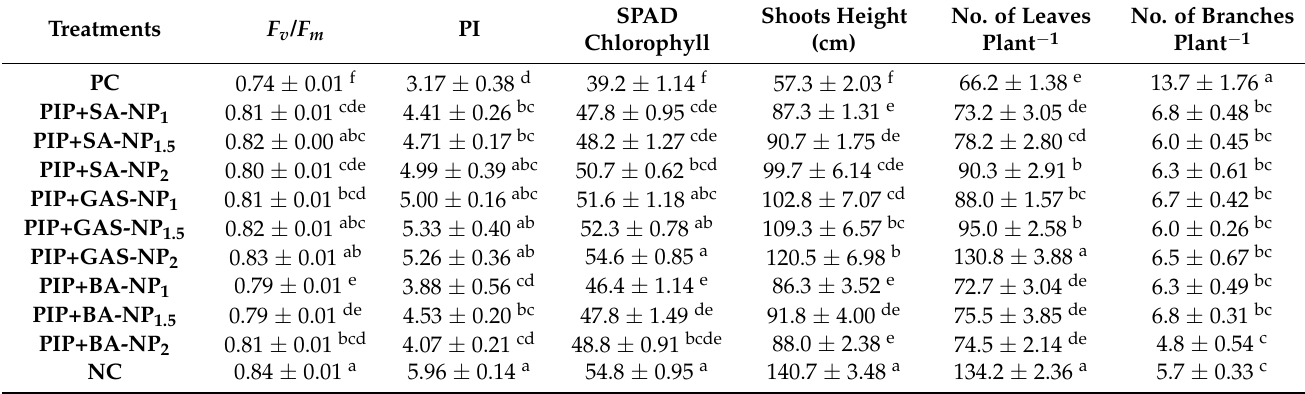
Table 3. Effects of foliar-applied salicylic acid (SA-NP), glycyrrhizic acid (GAS-NP), and boric acid (BA-NP) nanoparticles on the photosynthetic efficiency and growth parameters of phytoplasma- infected faba bean